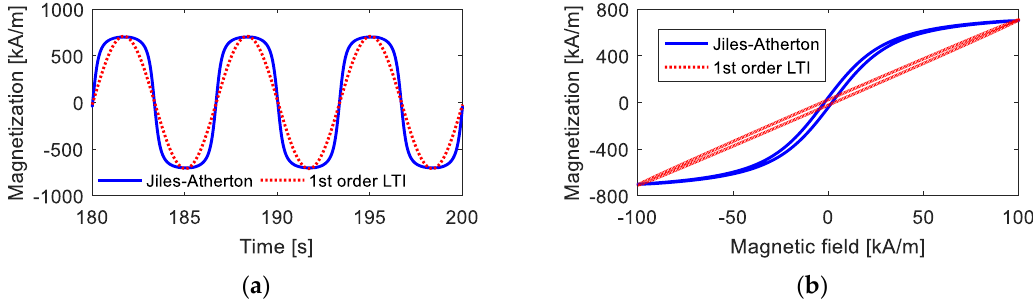
Figure 5. Magnetization curves under low magnetic field intensity calculated from the Jiles – Atherton model and the 1st − order LTI system model: ( a ) time − domain curves; ( b ) M − H curves.